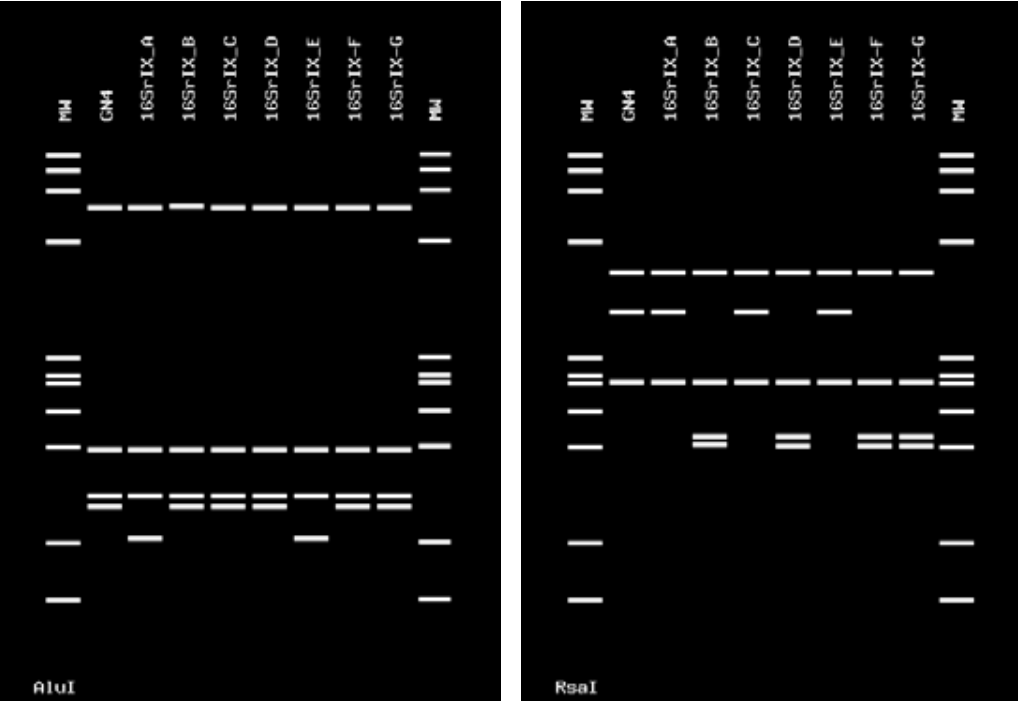
Figure 3. Virtual RFLP profiles obtained after simulated digestion with Alu I (left) and Rsa I (right) restriction enzymes of R16F2n/R16R2 nucleotide fragments from GN4 sample and from representative strains of 16SrIX